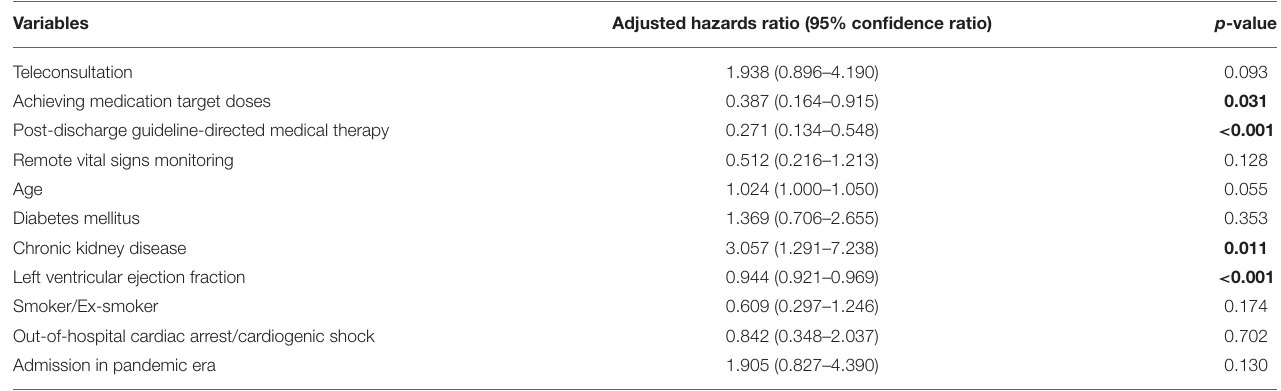
TABLE 4 | Cox regression for 1-year MACE in patients who survived index admission of